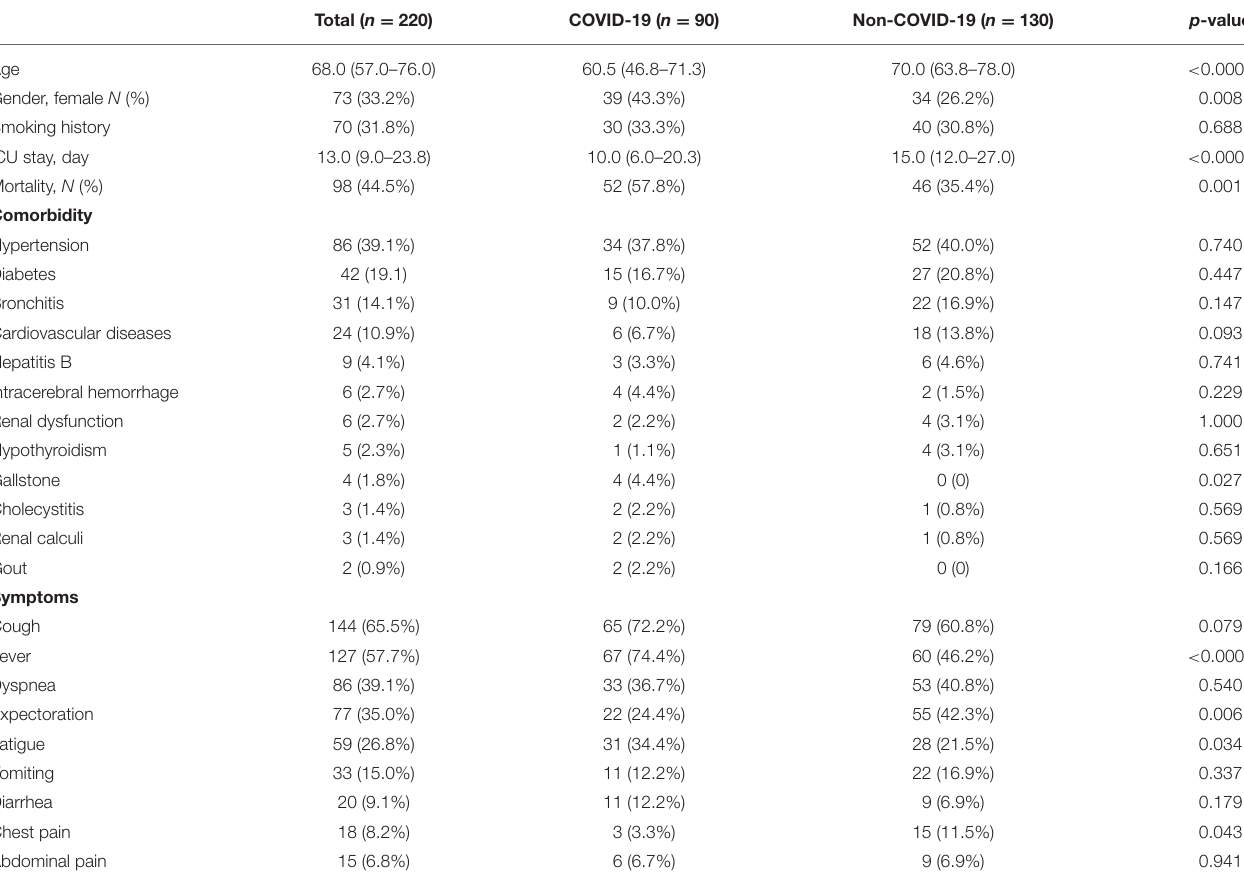
TABLE 1 | Demographic data, medical history, and clinical symptoms of 220 ALI